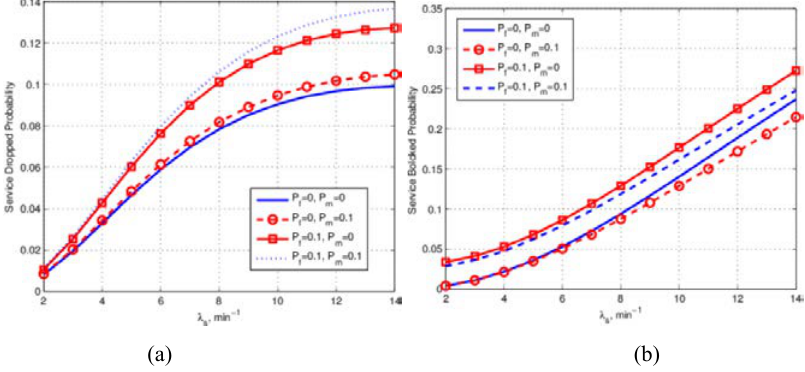
Fig. 4. (a) Service blocked probabilities for the OSA scheme with non-hopping under imperfect sensing; (b) Service dropped probabilities for the OSA scheme with non-hopping under imperfect sensing.